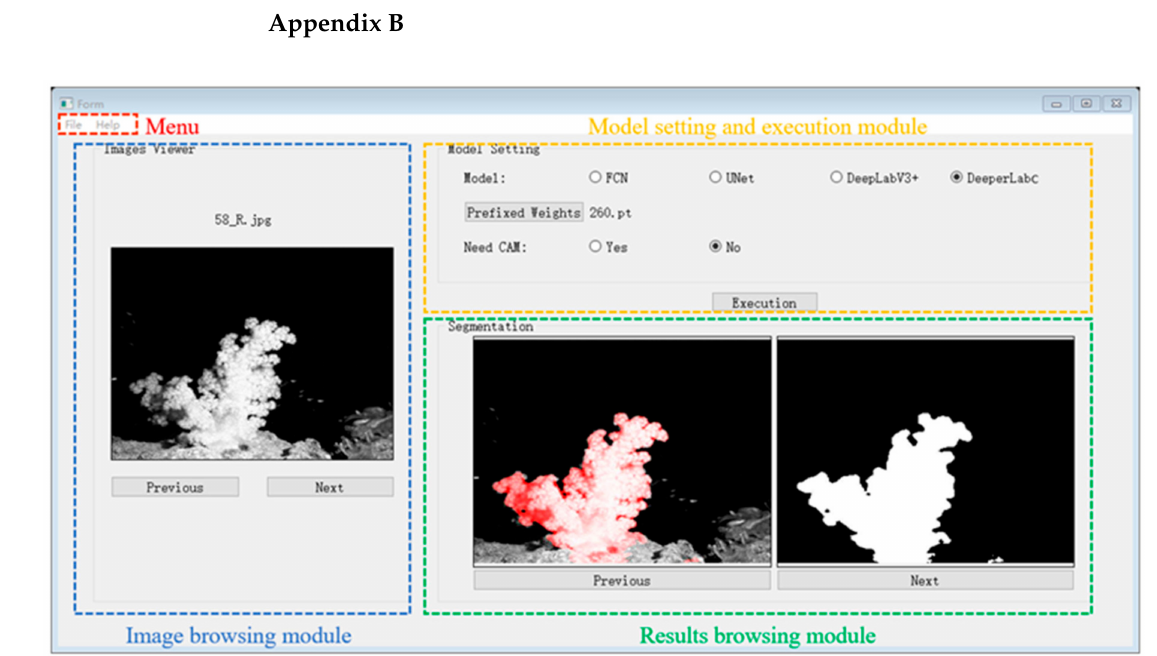
Figure A11. GUI interface for coral semantic segmentation